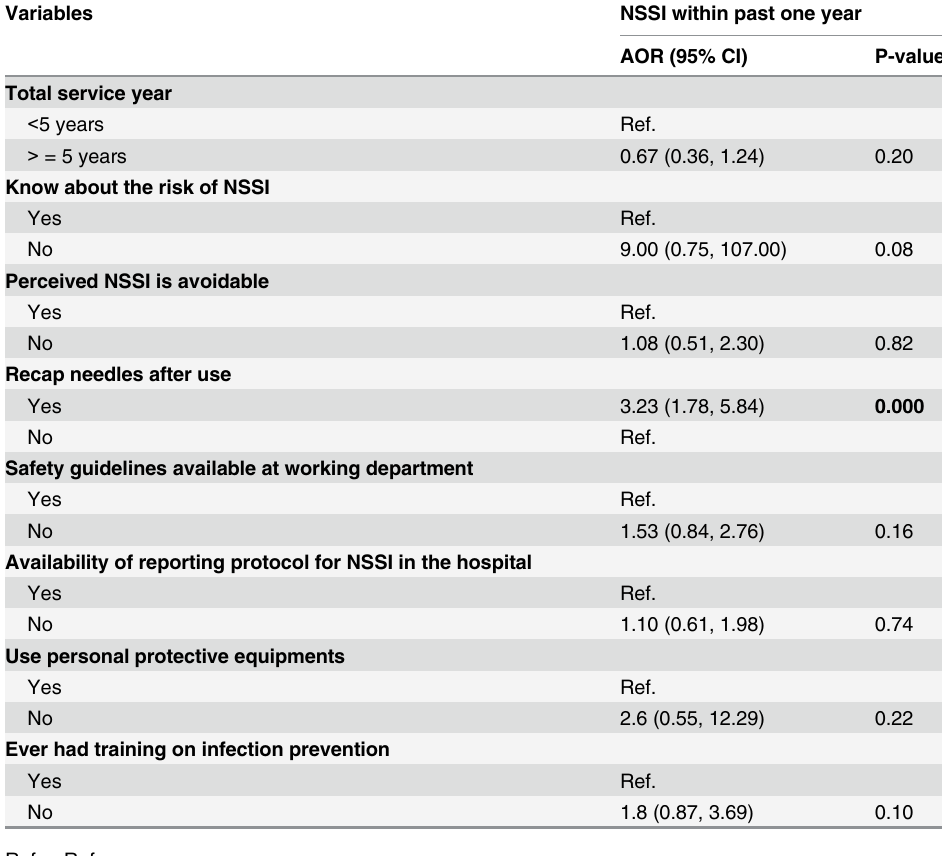
Table 4. Multivariable analyses of factors associated with needle stick and sharps injury in the past one year among hospital healthcare workers in Bale zone, December, 2014.